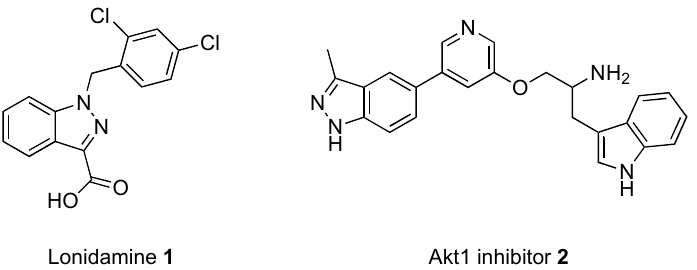
Figure 1. Relevant molecules with an indazole